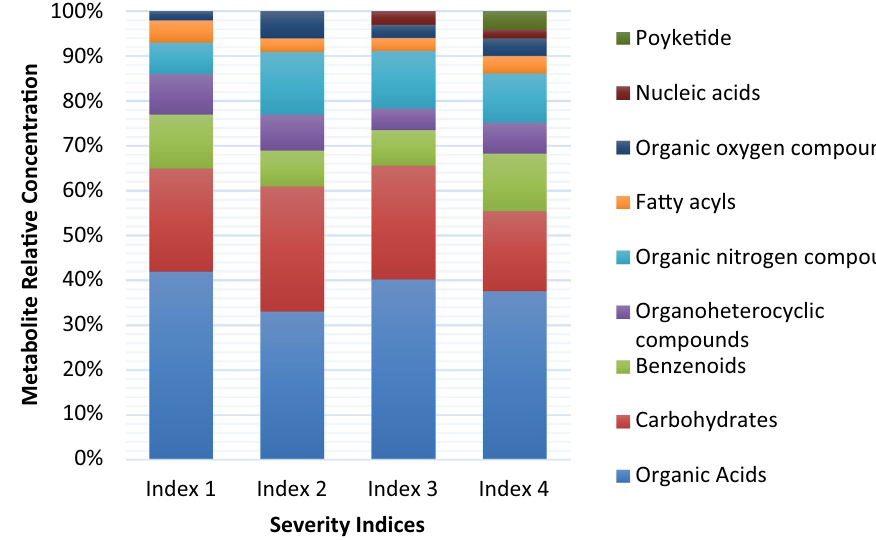
Figure 1. Metabolite profile of oil palm with 4 different severity indices. Each compound category is represented with relative percentages.